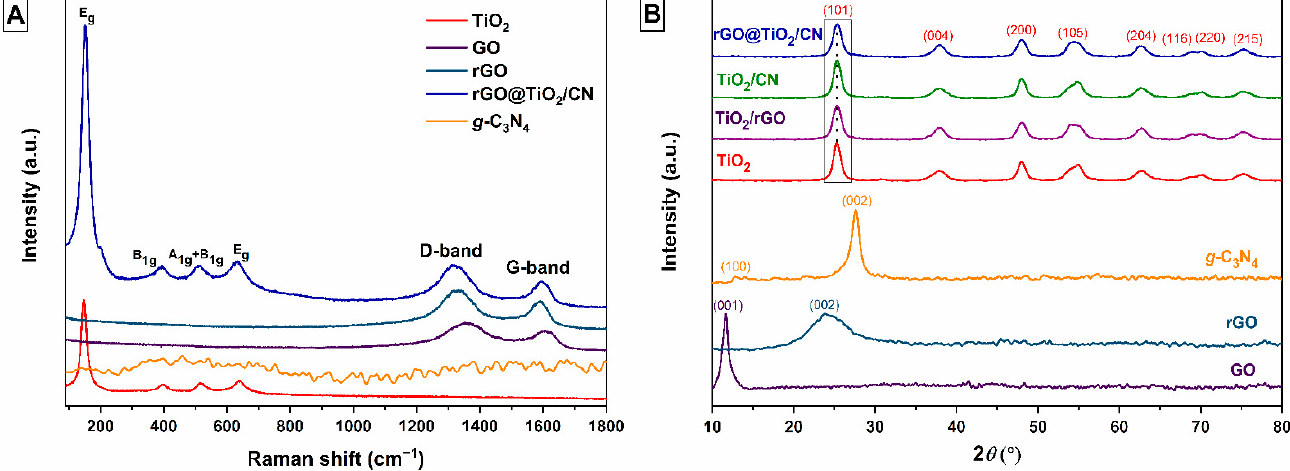
Table 1. Calculated crystallite size ( D , nm) of TiO 2 samples using the Scherrer equation.